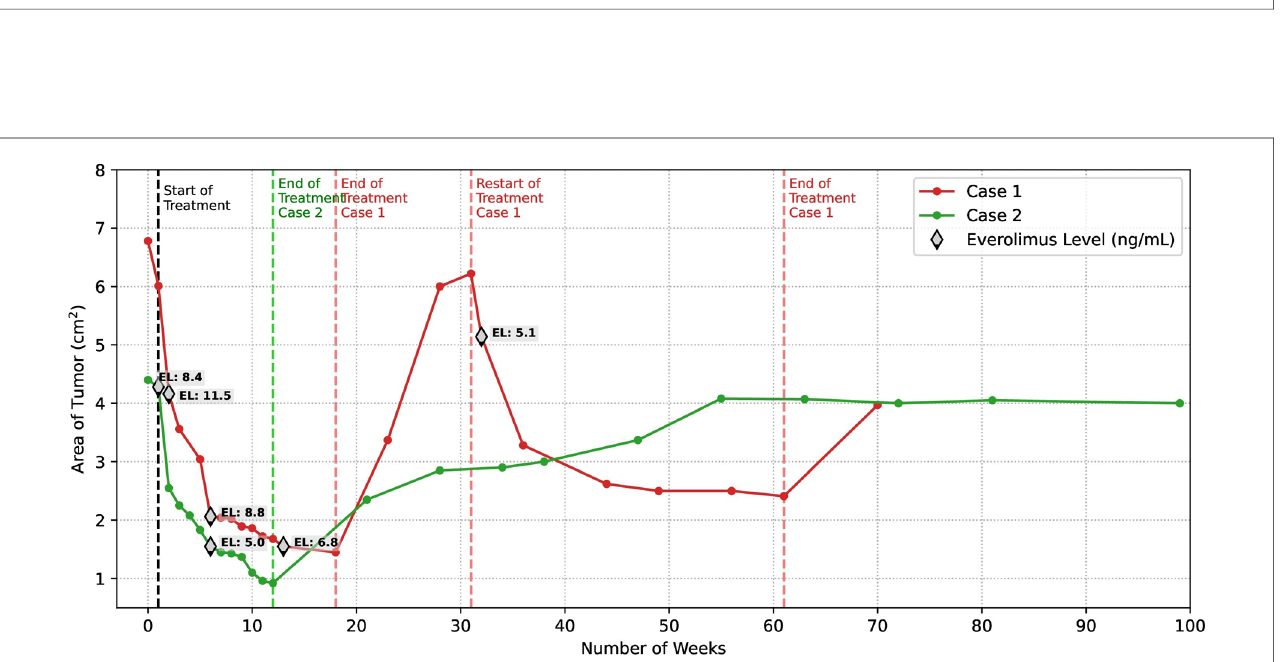
FIGURE 1 Case 1. ( A ) Immediate postnatal transthoracic echocardiogram in apical 4-chamber view showing a large hyperechogenic and homogeneous mass of 37 mm×20.7 mm in size (area of 6.78 cm 2 ), which occupies a large part of the right ventricular cavity, compatible with a giant rhabdomyoma. ( B – D ) Echocardiographic control at 2, 3, and 13 weeks after treatment with everolimus showed a signi fi cant reduction in the size of the rhabdomyoma.